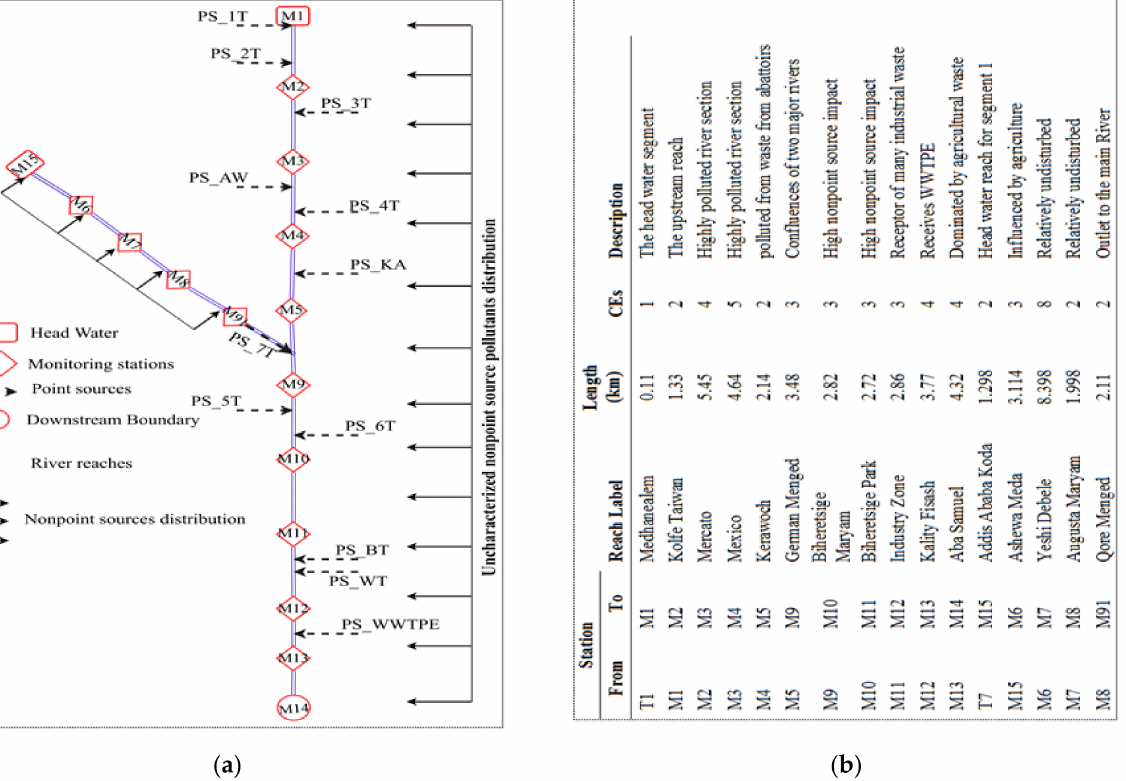
Figure 3. Segmentation ( a ) and labeling ( b ) of LAR for QUAL2Kw modeling (WWTPE = wastewater treatment plant